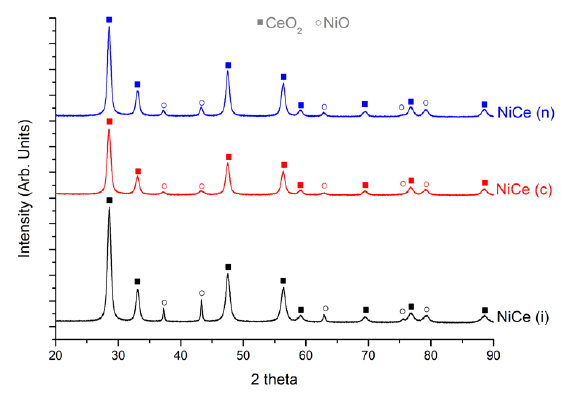
Figure 3. SEM images of the catalysts ( a ) NiCe (i); ( b ) NiCe (c); ( c ) NiCe (n). Table 2. NiO crystallite dimensions obtained by XRD analysis using the Scherrer equation; phase composition of the catalysts determined via XRD.